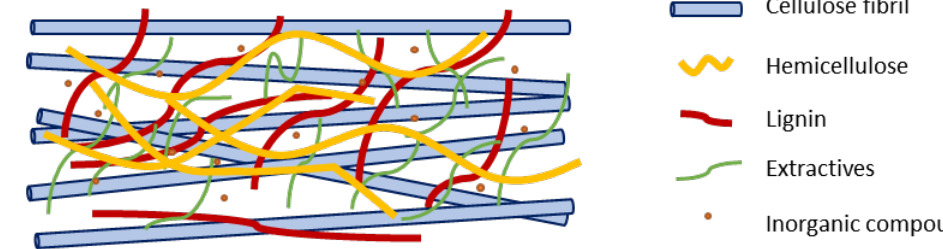
Figure 4. Illustration of the main chemical constituents in the fiber cell